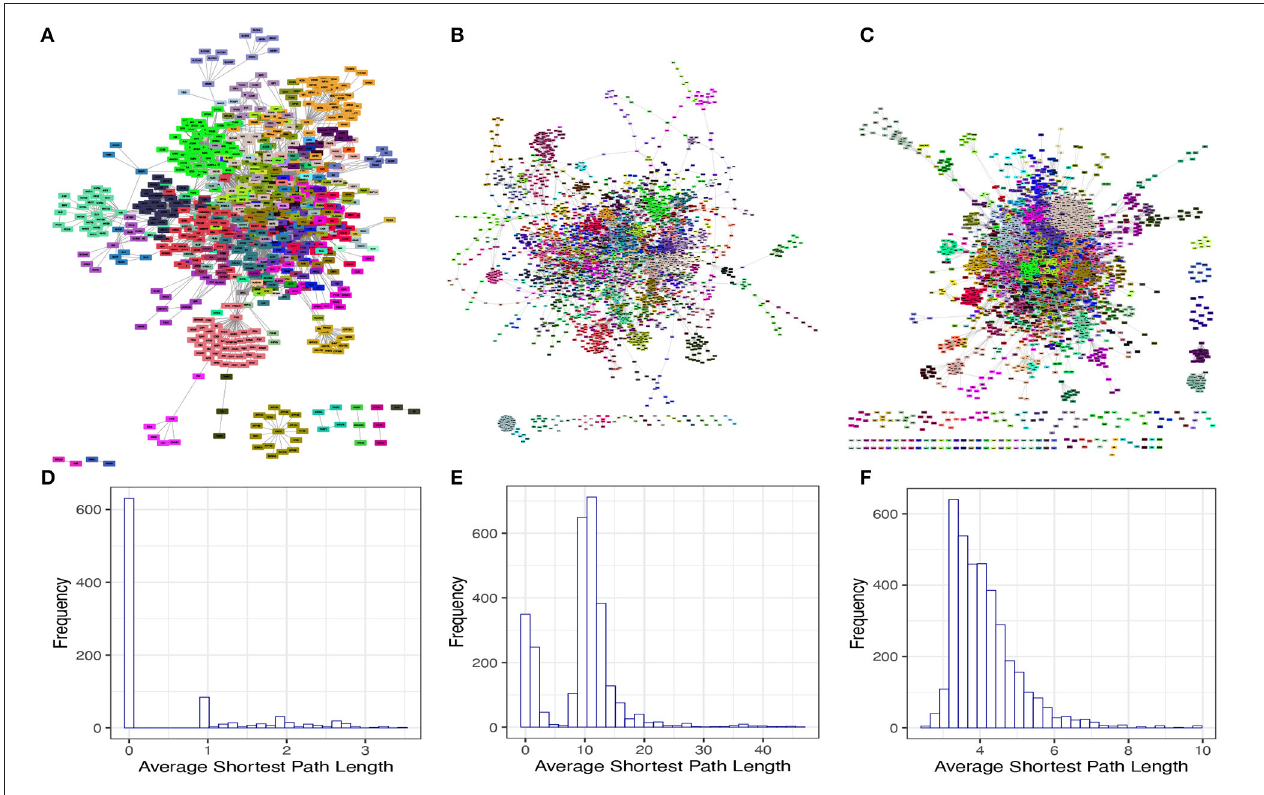
FIGURE 2 | Modular structure and average shortest path length distribution of the isolated networks. (A–C) shows the modular structure for TRN, MN, and PPN, respectively. The color identifies to which module each node belongs to. (D–F) shows the average shortest path length distribution for the GCC of the TRN, MN, and PPN,